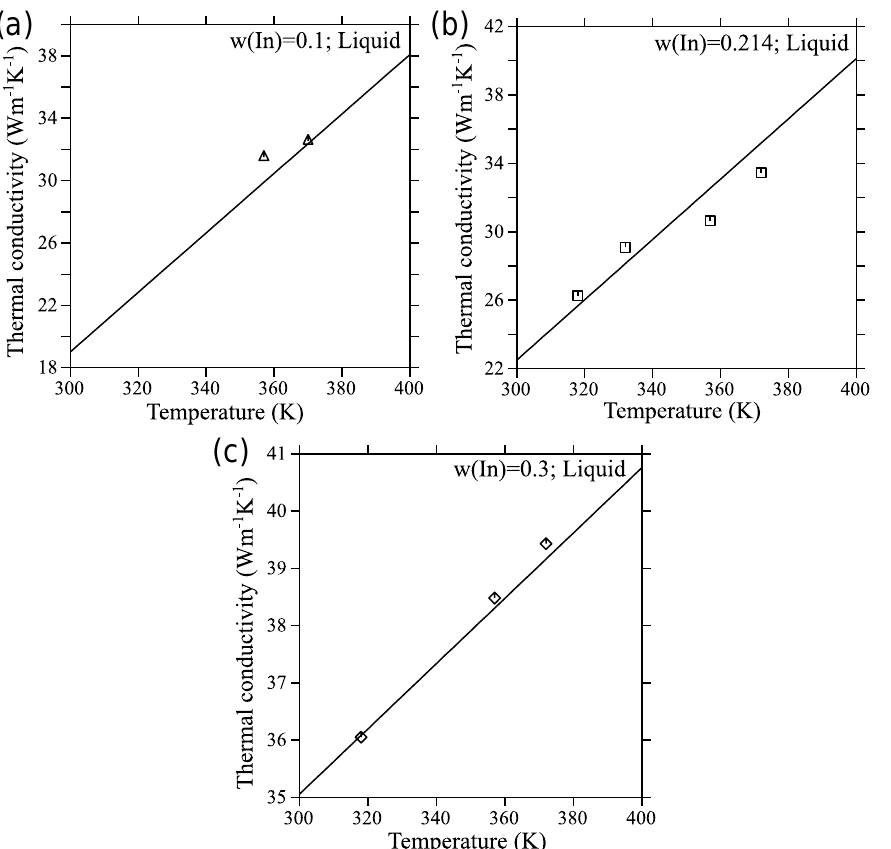
Figure 7. Comparison between calculated (solid line) and experimental (symbols) thermal conductivities of liquid Ga-In alloys at ( a ) w(In) = 0.1, ( b ) w(In) = 0.214 and ( c ) w(In) = 0.3.